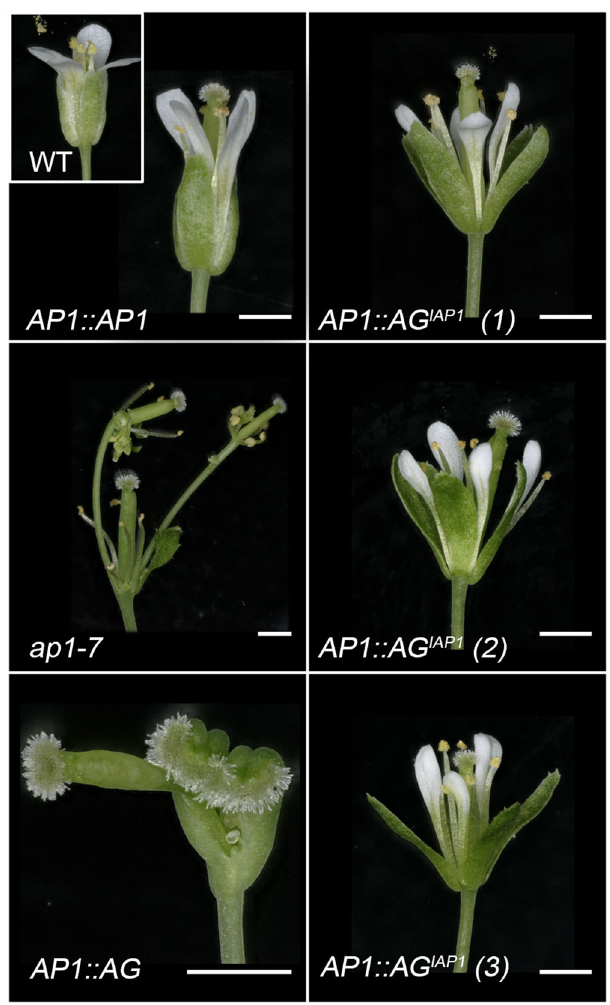
Fig. 6 AP1:AG IAP1 expression largely complements the ap1 -7 fl ower phenotype. ap1 -7 lines expressing either AP1 ( AP1::AP1) , AG ( AP1::AG) or AG IPA1 ( AP1::AG IAP1 ) under the control of the AP1 promoter were grown at 22 °C in long days. A typical WT fl ower is shown as an insert in the upper left panel. Representative fl owers for three independent AP1::AG IAP1 lines are presented and one representative fl ower from AP1::AG and AP1::AP1 expressing lines. While the fi rst whorl in ap1-7 is replaced by bract or stipule with axillary buds and petals are missing in the second whorl, AP1:: AG IAP1 expression restores WT fi rst and second whorl organs, while AG expression triggers carpel development in the fi rst whorl and absence of petals in the second whorl. Scales bars = 1